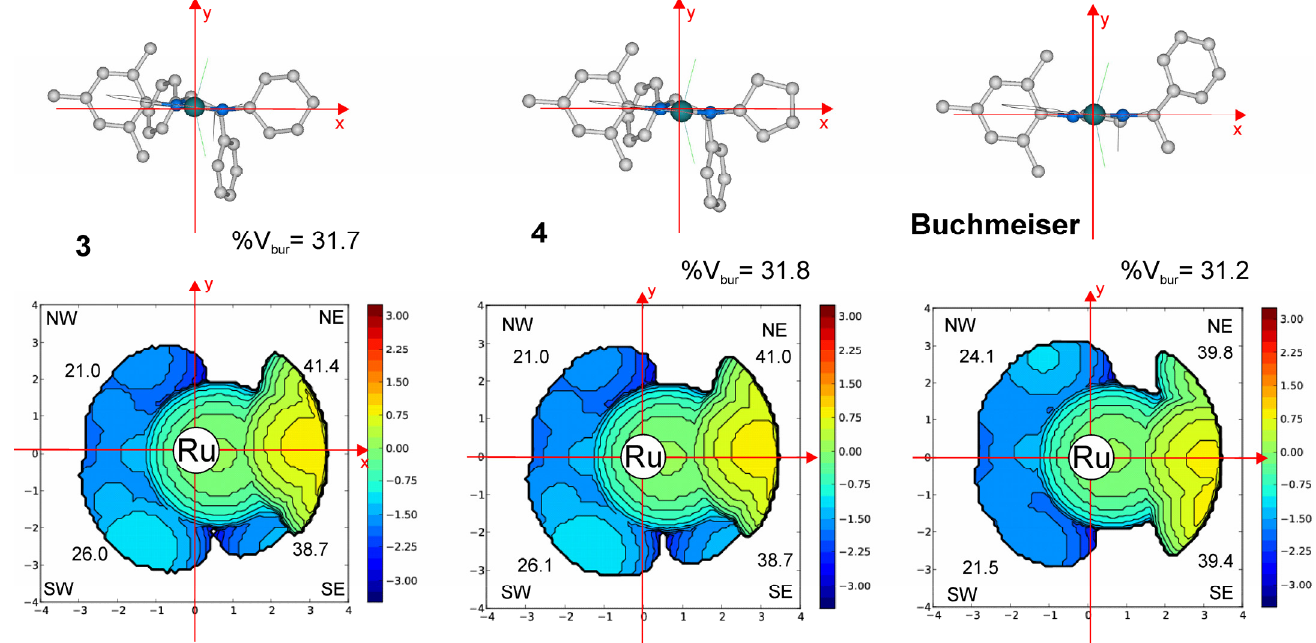
Figure 8. Topographic steric maps of 3 [45], 4 and Buchmeiser catalyst. The iso-contour curves of steric maps are in Å. The maps were constructed starting from the minimum energy structures of complexes optimized via DFT calculations. The complexes are oriented according to the structure on the top of the map. Overall % V Bur and % V Bur representative of each single quadrant are reported for each map. % V Bur is a parameter that quantifies the steric hindrance of ligands and is defined as the fraction of the total volume of a sphere centered on the metal occupied by a given ligand [56,57]. Quadrants in topographic steric maps are identified as NW, NE, SW and SE, according to their position on the map.